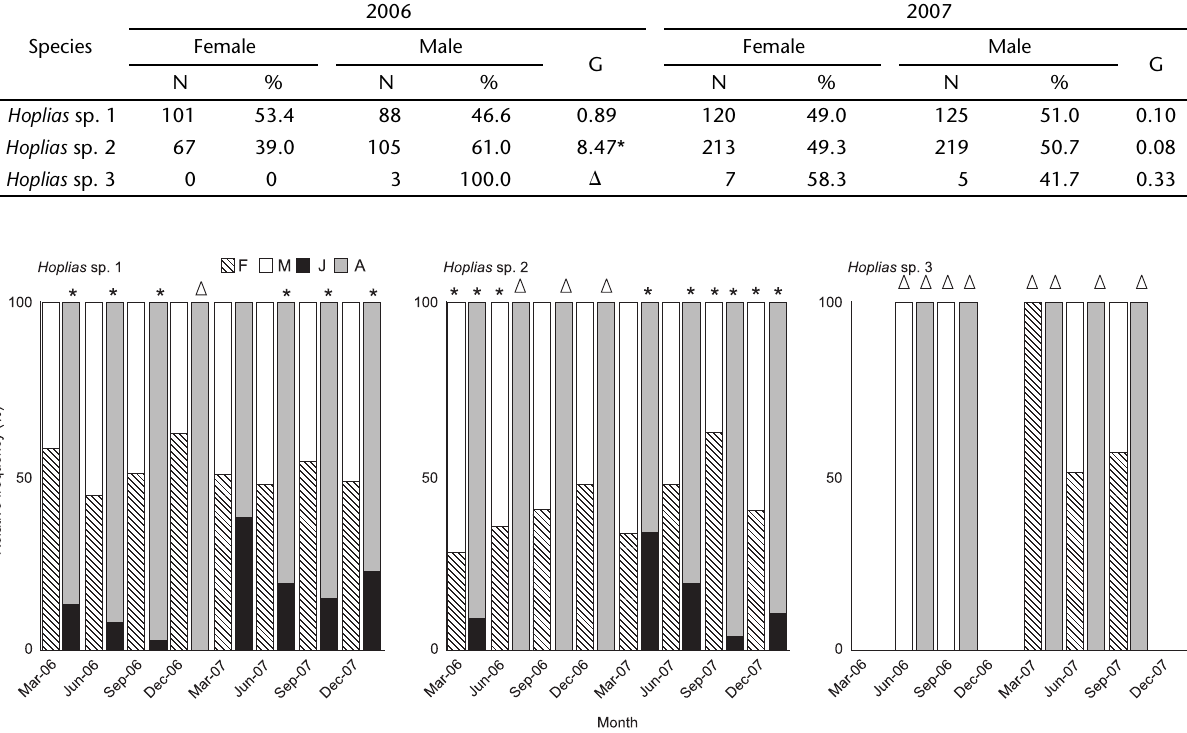
Figure 4. Quarterly variation in the relative frequencies of males (M) and females (F) and juveniles (J) and adults (A) of Hoplias sp. 1, Hoplias sp. 2 and Hoplias sp. 3 in the Upper Paraná River floodplain. * significant at the level of 5%; (cid:2) = impossible to calculate G.